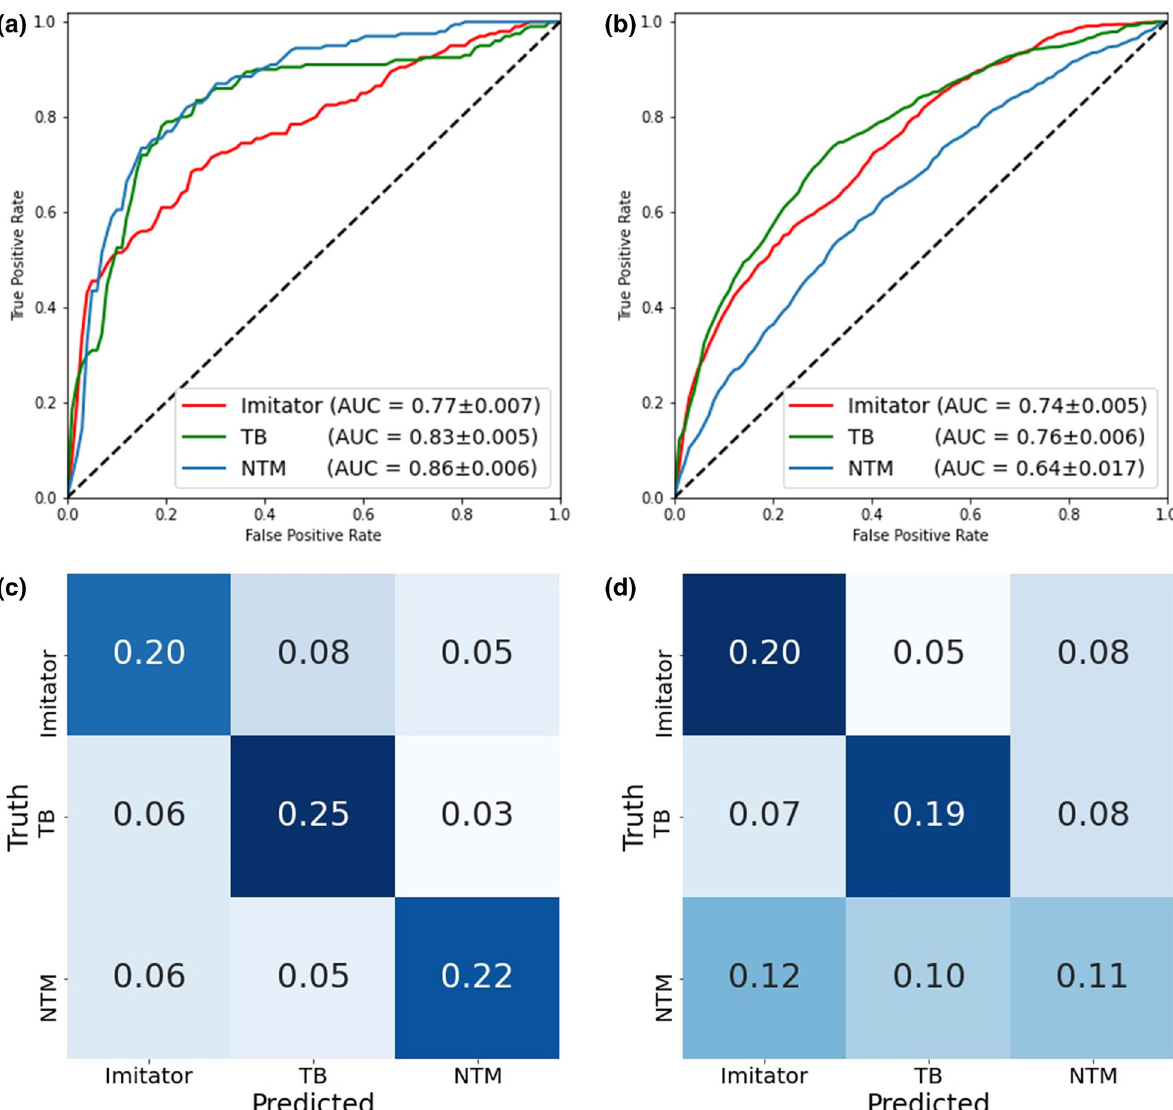
Fig. 3 One‑vs‑others receiver operating characteristic (ROC) plots of our deep neural network (DNN) tested in the internal ( a ) and external ( b ) test sets are presented. Overall, the model showed acceptable generalizability for Imitator and tuberculosis (TB) predictions between the two tests. While the model was best at predicting non‑tuberculous mycobacteria (NTM) in the internal cohort, it achieved the worst result in external cohort. This finding might come from great heterogeneity between NTM groups in the internal and external test sets. c , d demonstrates confusion matrices of DNN’s performance ( c ) and the pooled performance of the 12 pulmonologists ( d ) on the internal test set. The major distinction between human experts and machines can be found in NTM prediction. Even though the recruited pulmonologists are experts of mycobacterial diseases, they tended to make random guesses when chest X‑rays (CXRs) of NTM were presented to